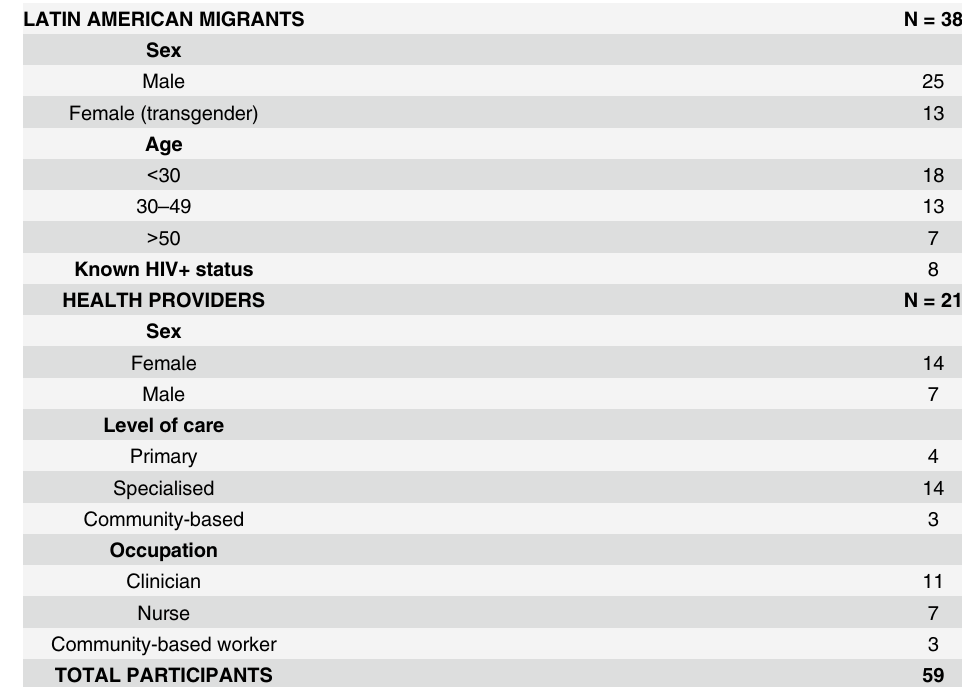
Table 1. Characteristics of study participants (N =